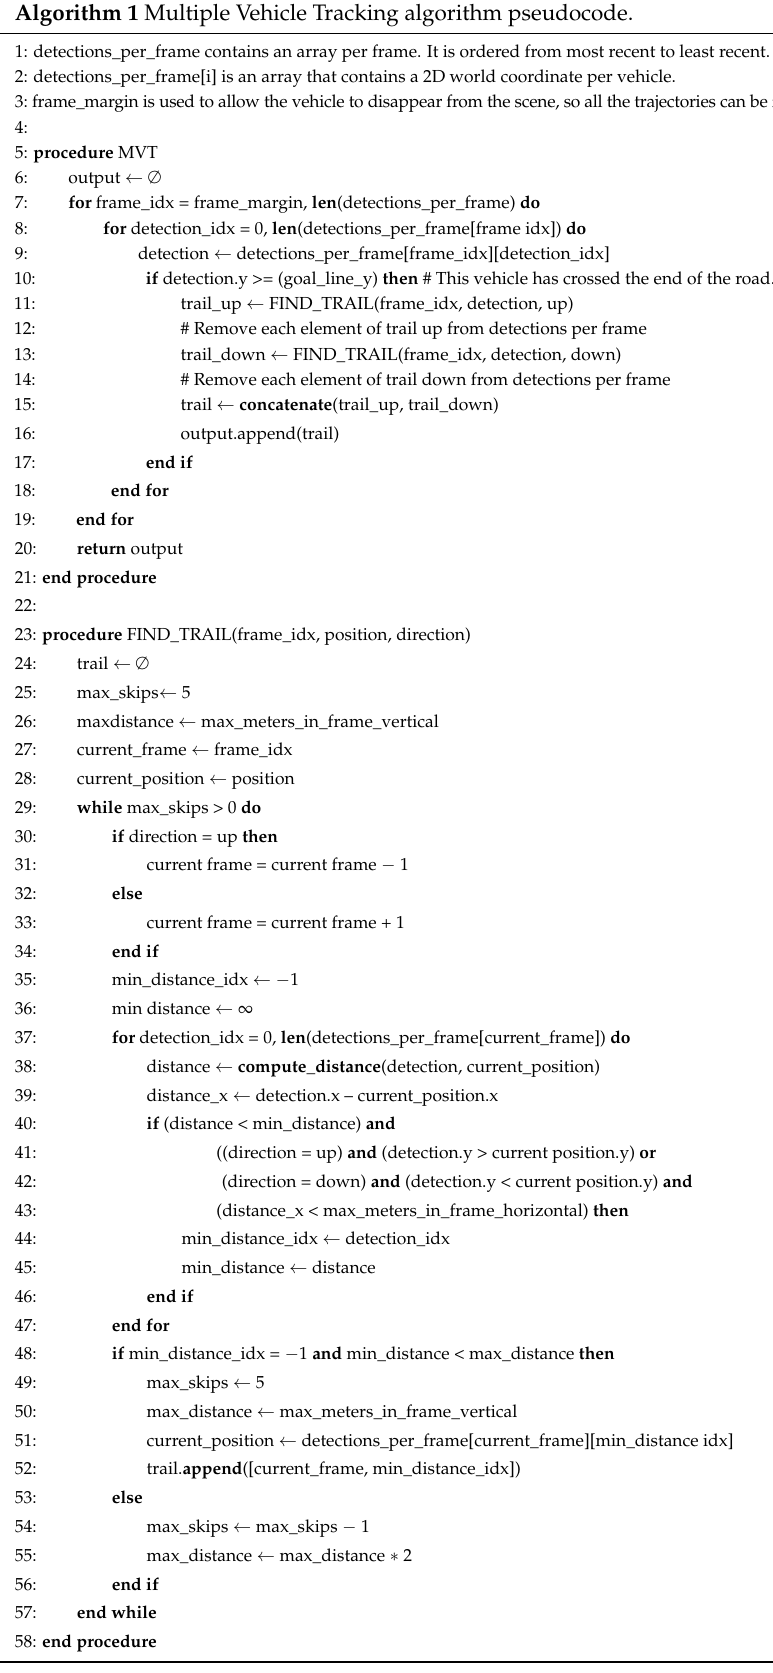
Algorithm 1 Multiple Vehicle Tracking algorithm